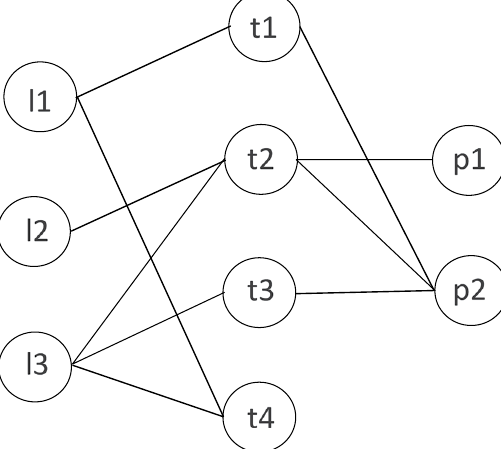
Figure 8. Example of calculating HeteSim